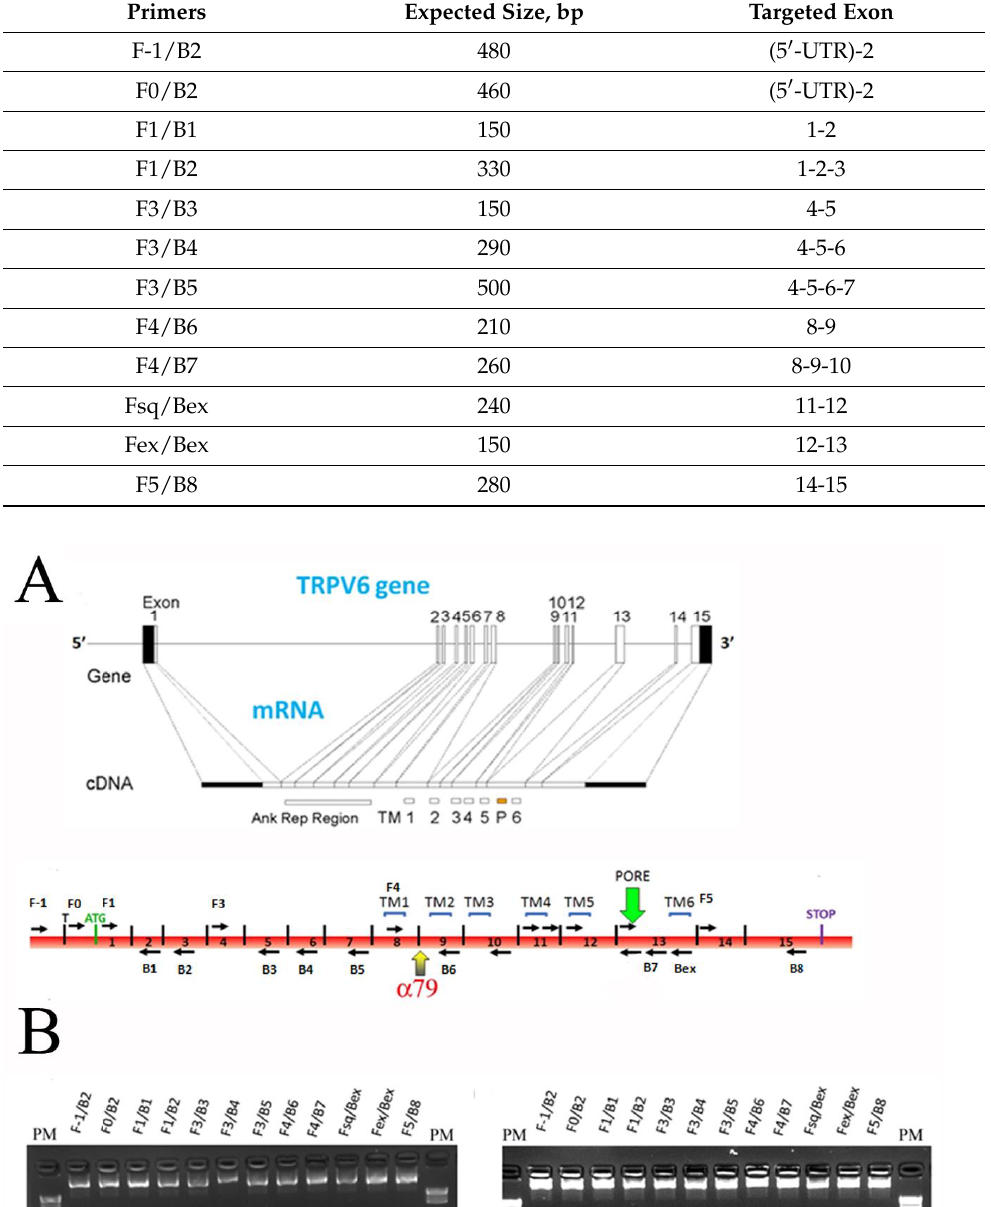
Table 3. List of the primers used for RNA-profiling and the expected sizes of the PCR amplicons.